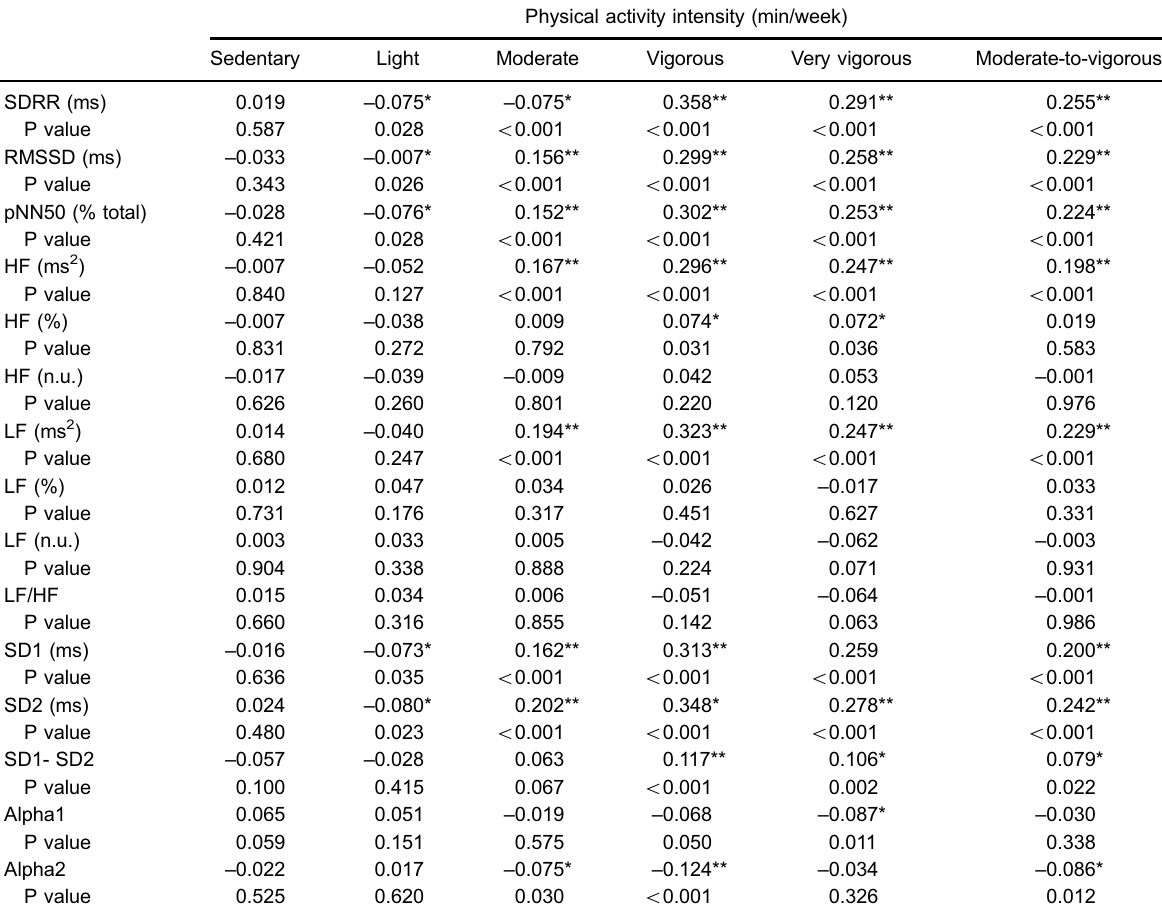
Table 2. Correlation coef fi cients of the indices of the heart rate variability (HRV) and physical